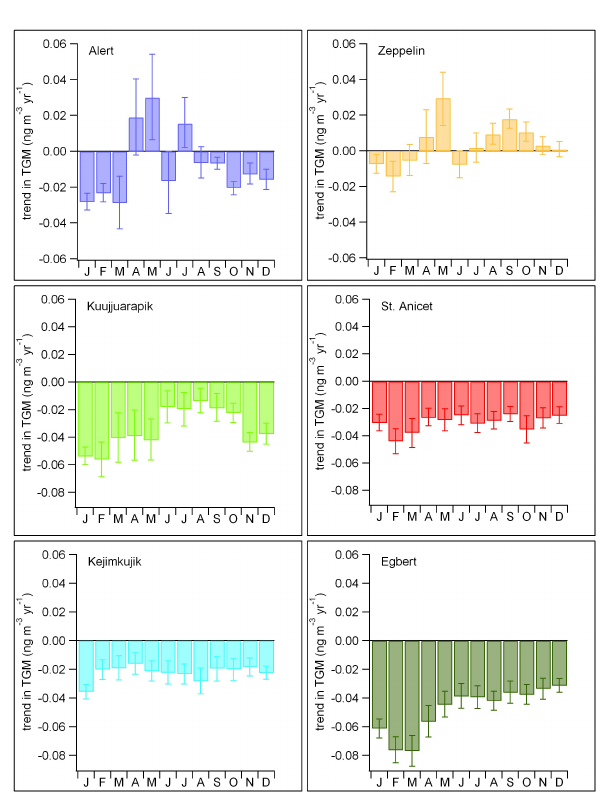
Fig. 2. Seasonal (monthly) trends in TGM based on daily average measurements 2000–2009. Error bars represent 95% confidence